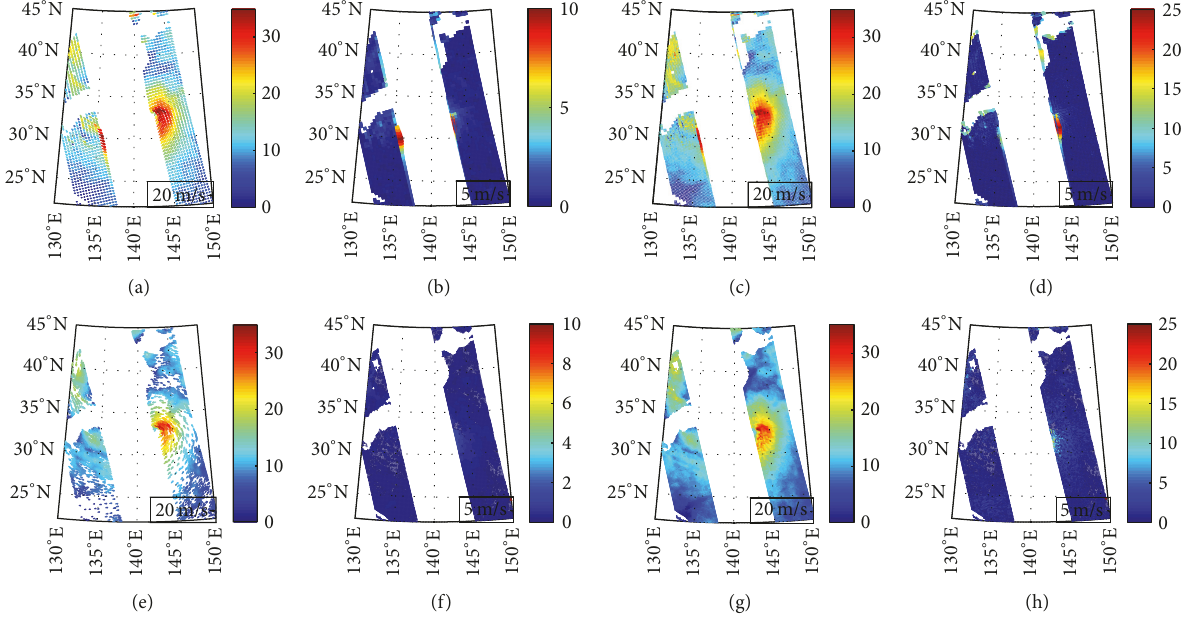
Figure 4: Comparison of superobbing with different box. (a) Wind field using superobbing with regular box. (b) Standard deviation of innovation within regular box. (c) Resampled wind field using regular box. (d) Resampling error using regular box. (e) Wind field using superobbing with feature box. (f) Standard deviation of innovation within feature box. (g) Resampled wind field using feature box. (h) Resampling error using feature box.